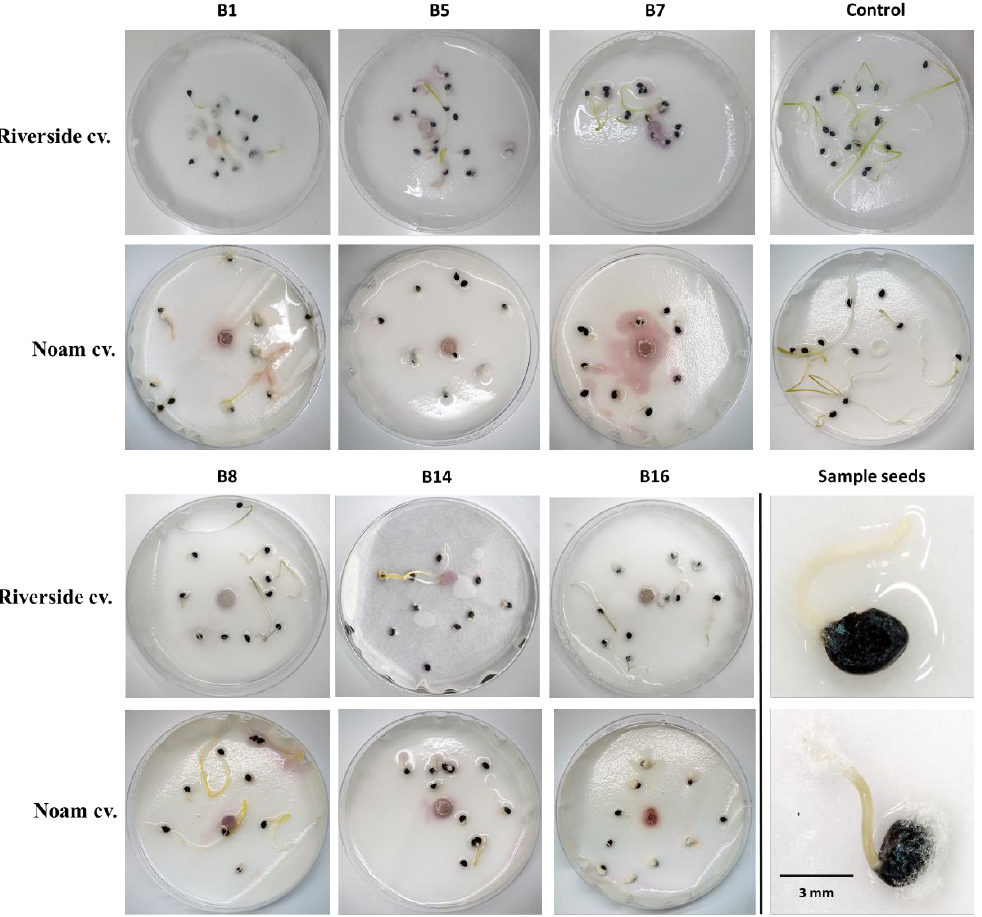
Figure 7. Seedling pathogenicity assay. Onion seeds of the Riverside (Orlando) and Noam cultivars were inoculated with six Fusarium isolates—B1, B5, B7, B8, B14, B16 (Table 2). Each group of 10-15 germinating seeds was inoculated with a 6-mm-diameter disc from a 5-day Fusarium sp. colony placed in the middle of the petri dish. A sterile 6-mm-diameter PDA disc was added to the control group. Sample seeds photos show minor (upper photo) or massive (lower photo) Fusarium white mycelial growth on or near the onion seeds. Photos were taken nine days after incubation at 28 ± 1 °C in the dark.